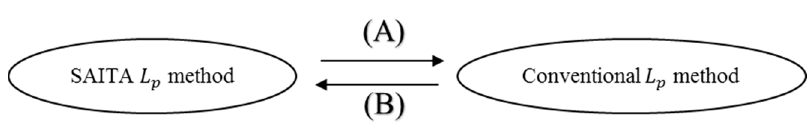
Figure 1. The relationship between the conventional single dictionary based L p thresholding method and the proposed SAITA L p method.